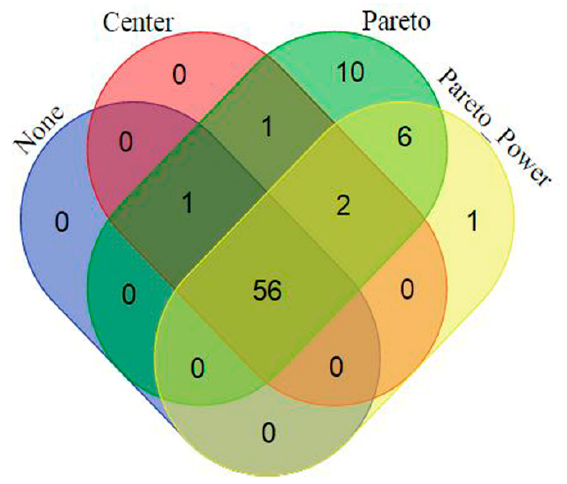
Figure 5. Venn diagram displaying (comparatively) the statistically-selected discriminating variables from the four OPLS-DA models that are statistically valid (Table 3). As indicated in the diagram, there are unique and shared discriminating variables from the four models i.e., different data pre-treatment (scaling and transformation) methods led to different discriminating variables.